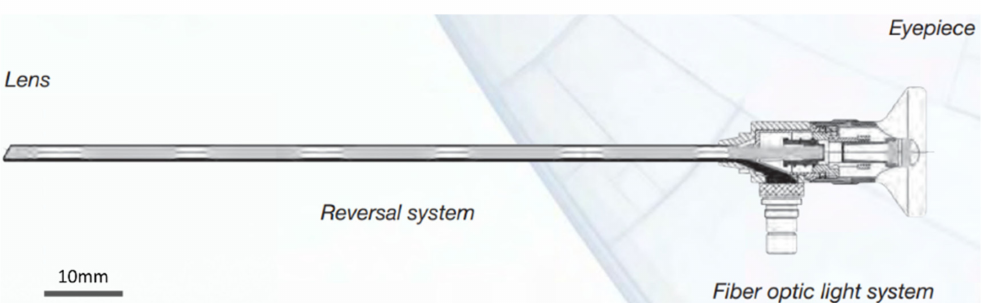
Figure 21. Structure of an endoscope. © Karl Storz SE & Co KG.